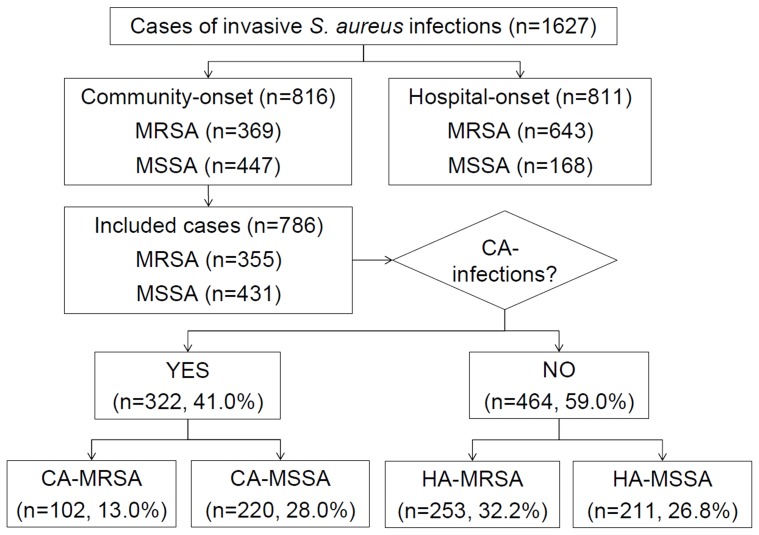
Schematic diagram describing the classification of Staphylococcus aureus infections as community-associated (CA) or healthcare-associated (HA) according to methicillin-resistance (MRSA) or methicillin susceptibility (MSSA).